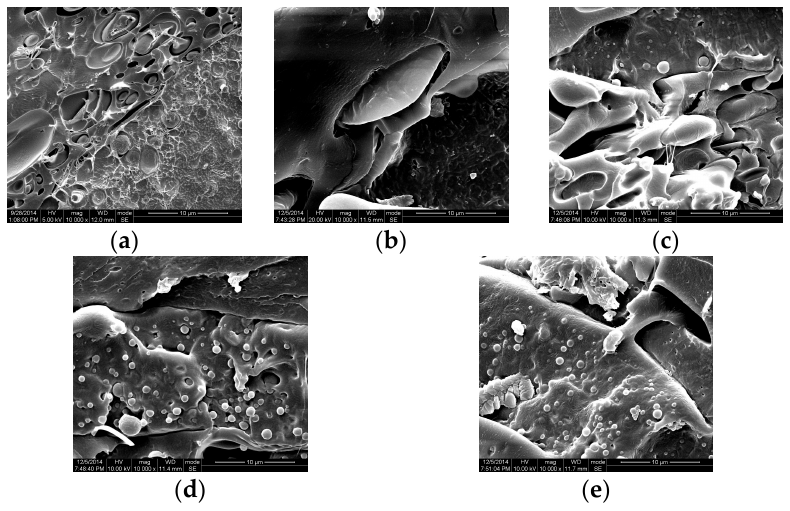
Figure 1. SEM micrographs of the fracture surfaces morphology of ( a ) PLA/PTMC; ( b ) PLA/PTMC/O3; ( c ) PLA/PTMC/O6; ( d ) PLA/PTMC/O9; and ( e ) PLA/PTMC/O12 (magnification: 10,000×).